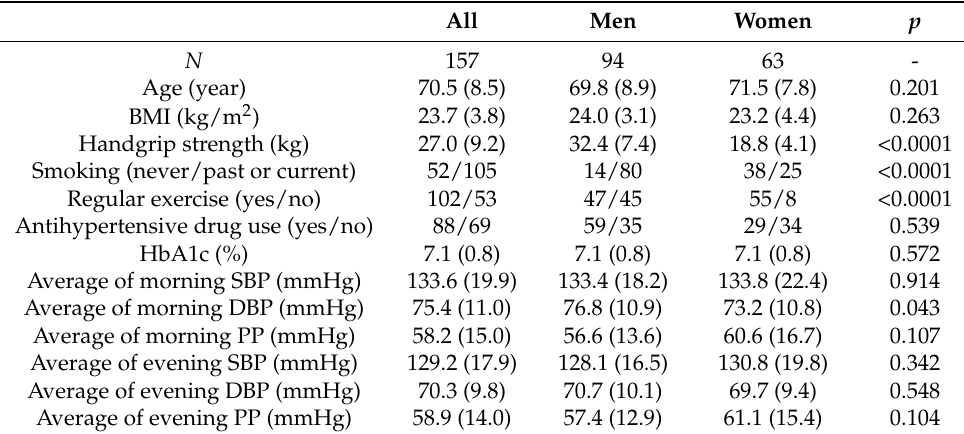
Table 1. Clinical characteristics of study participants.